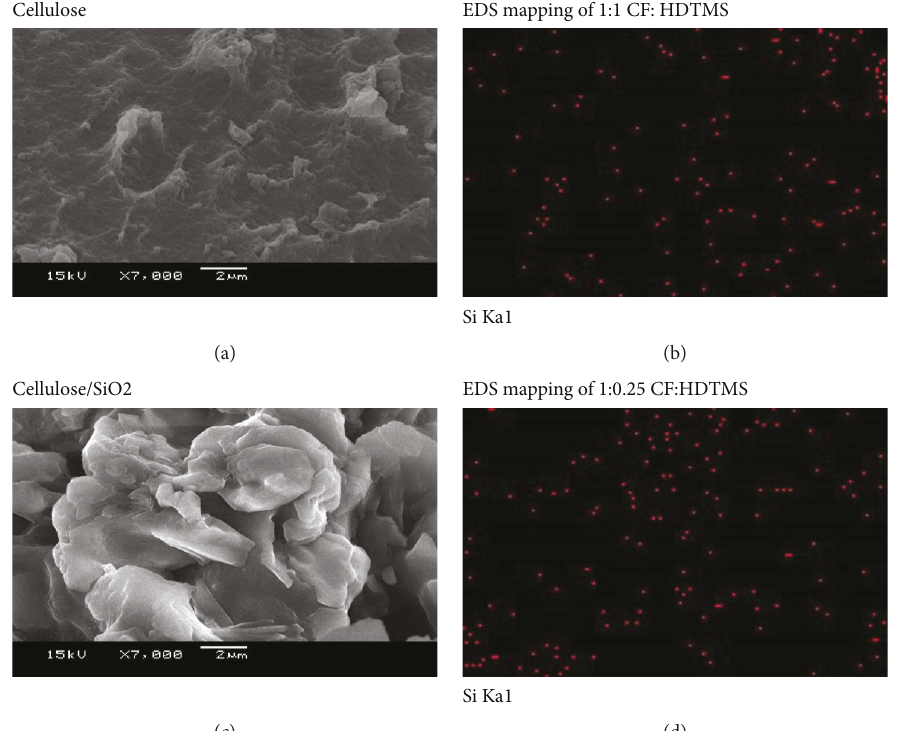
Figure 2: SEM images (a, c) of cellulose and cellulose/nanoSiO